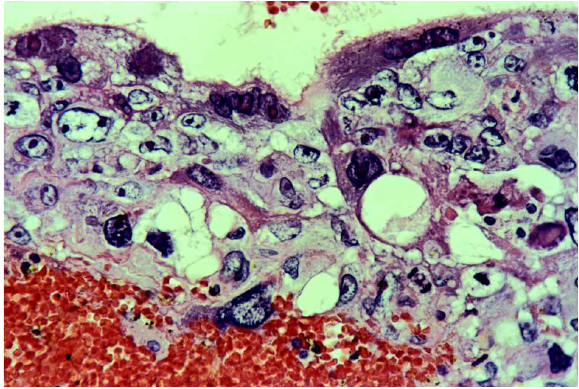
Figure 2 – Photomicrography of urethral neoplasia showing sincitiotrophoblast-like giant cells (above), recovering the large and vacuolized polygonal cells (below), HE